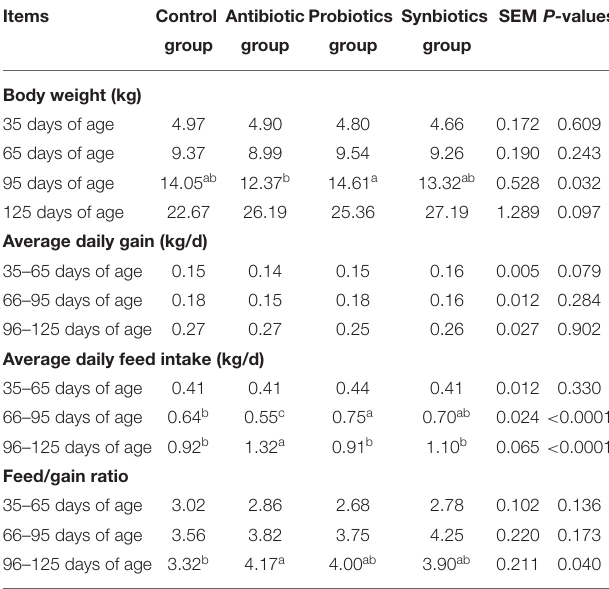
TABLE 1 | Effects of probiotics and synbiotics addition in sows’ diets on growth performance of offspring pigs.